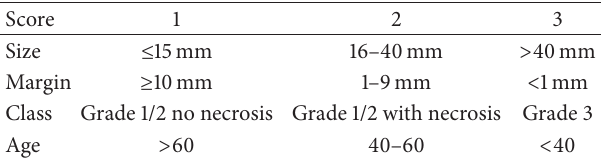
Table 1: Scoring system for the University of Southern Califor- nia/Van Nuys Prognostic